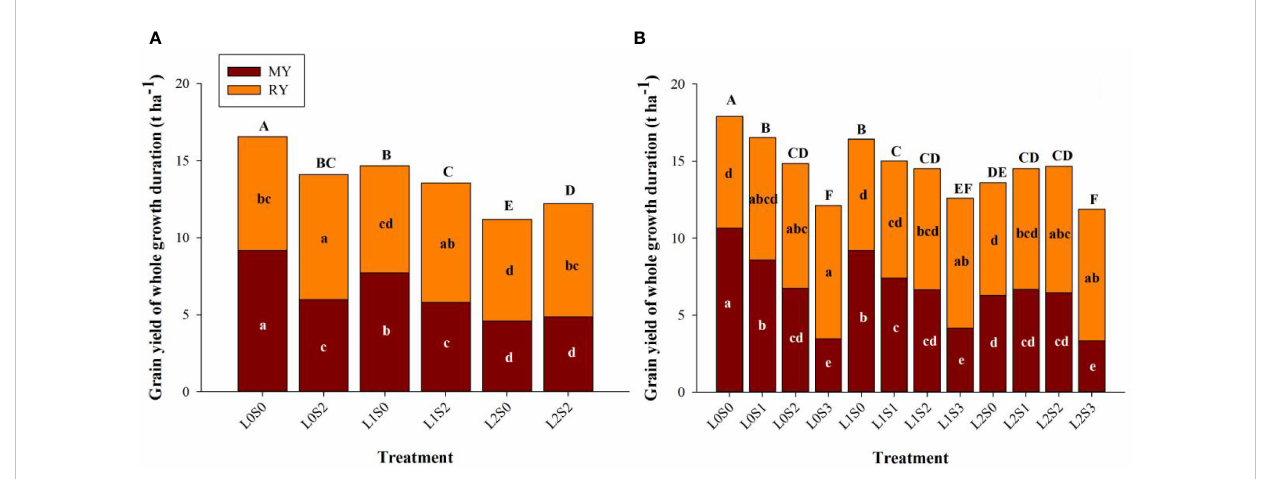
FIGURE 3 Effects of leaf cutting and spikelets thinning on grain yield in main crop, ratoon crop and annual yield in 2018 (A) and 2019 (B) . L0 represent the treatment of no leaf-cutting; L1 represent the treatment of cutting top of one leaf; L2 represent the treatment of cutting top of three leaves; S0, S1, S2 and S3 represent the treatment of thinning 0, 1/4, 1/2 and 3/4 spikelets, respectively. MY and RY represent the grain yield in main crop and ratoon crop, respectively. The different lower-case letters on the same color column and upper-case letters between different treatments in the same year all showed signi fi cant differences at the 0.05